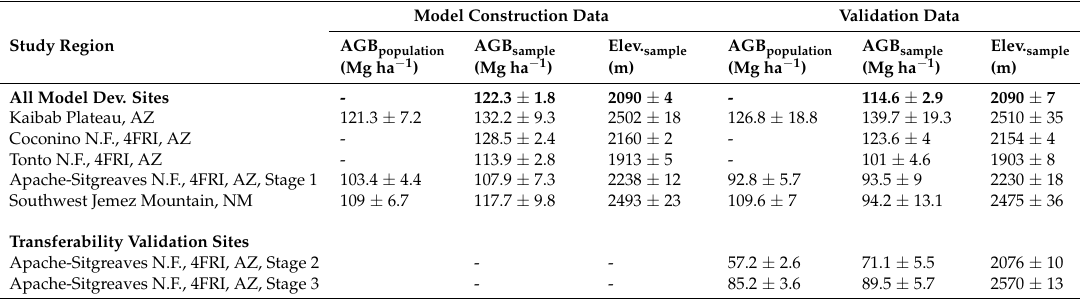
Table 4. Sample and population summary statistics from the field data for each project. Estimates are provided for both the model calibration and validation data subsets. Mean and standard error of above-ground biomass (AGB) and elevation are